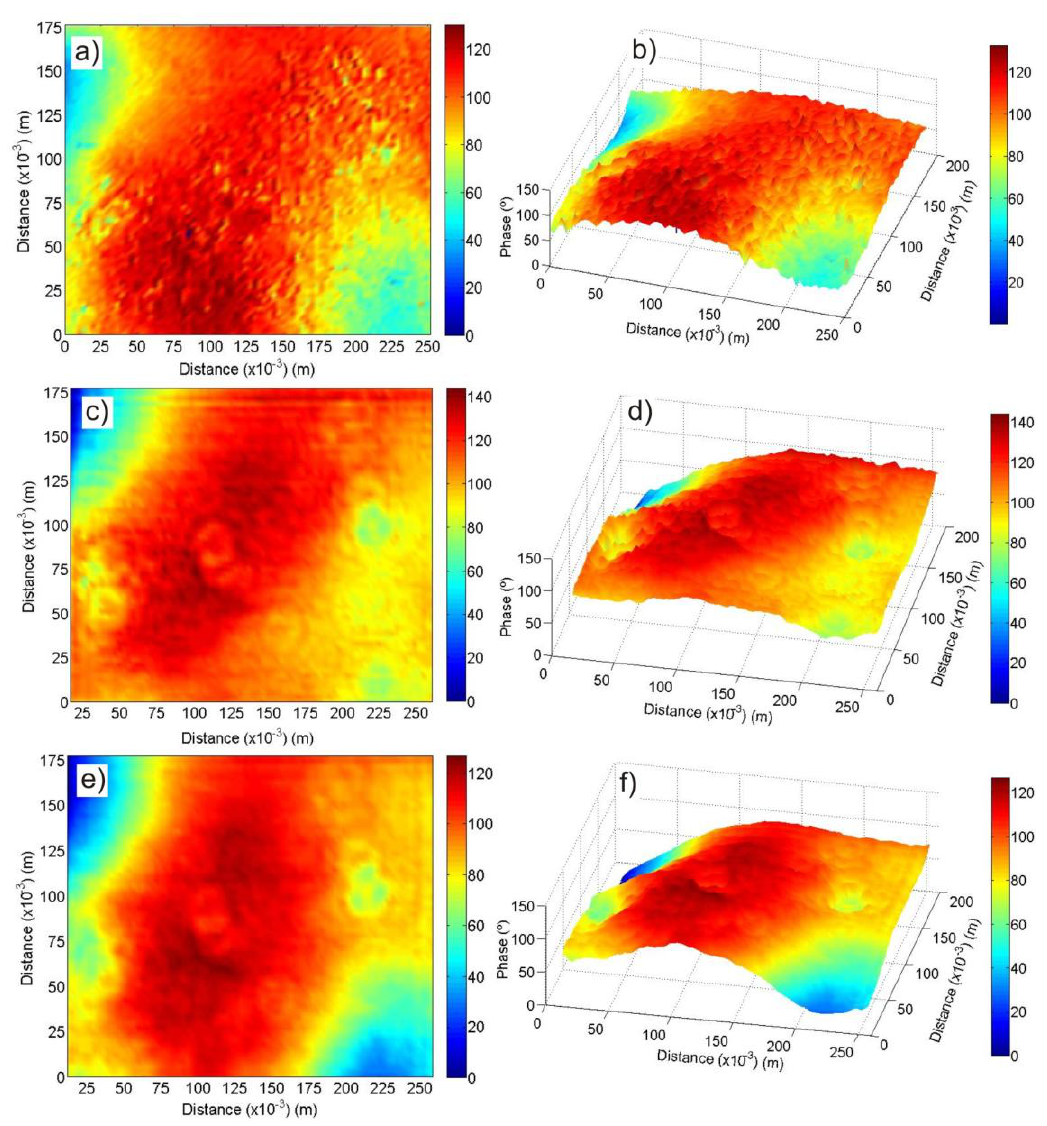
Figure 4. ( a , b ) Fresnel image results; ( c , d ) PSA image results for the TR40 transducers; ( e , f ) PSA image results for the 400ST transducers. A two-dimensional and three-dimensional view of each section is